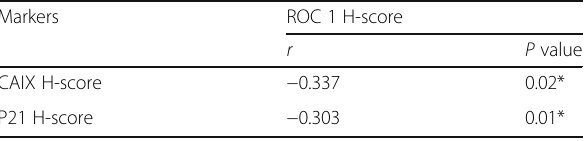
Table 5 Correlation between ROC-1 H score and both CAIX and P21 H-scores in malignant cases Markers ROC 1 H-score r P value CAIX H-score − 0.337 0.02* P21 H-score − 0.303